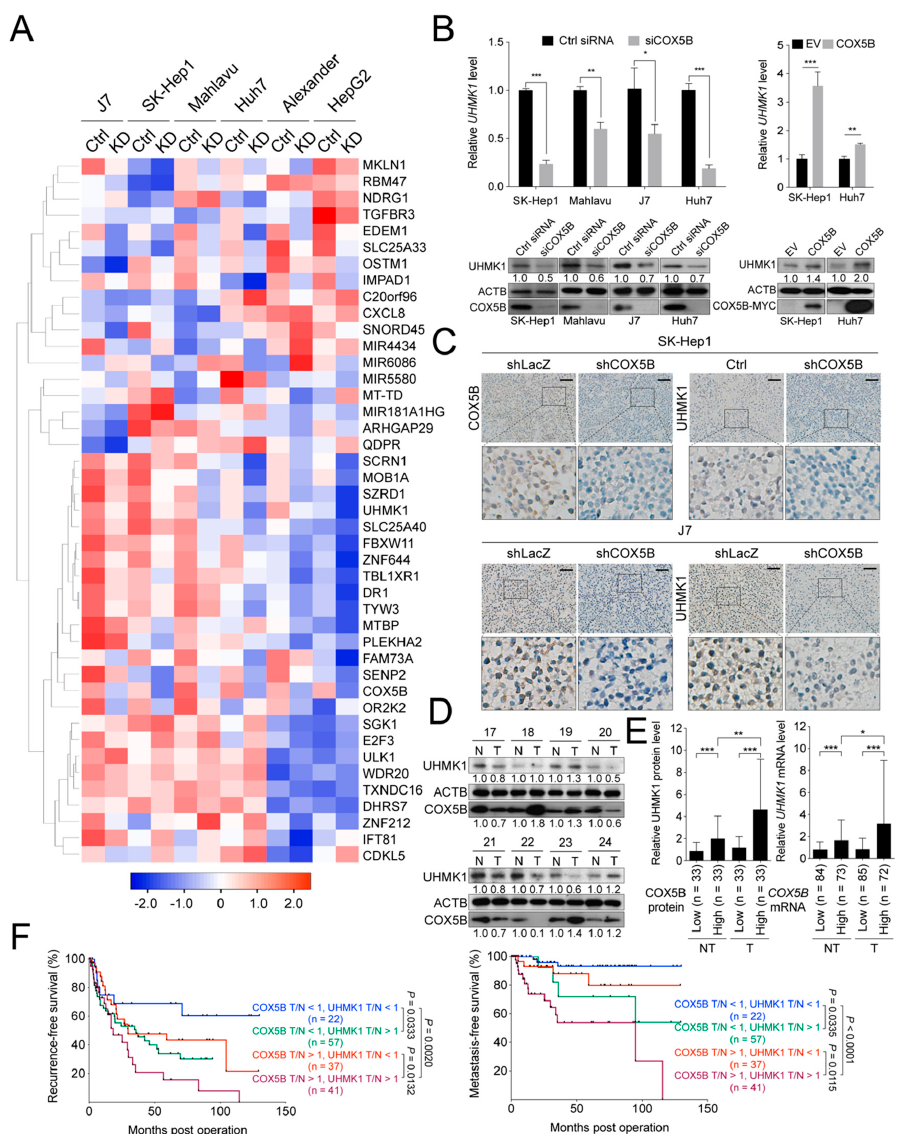
Figure 4. COX5B modulates UHMK1 expression in hepatoma. ( A ) The heat map representation of the relative gene expression levels in hepatoma cells receiving control treatment (Ctrl) and knockdown of COX5B (KD). The average linkage method was used for hierarchical clustering. The distances between rows and columns were computed by Pearson method. ( B ) RT-qPCR and western blot were performed for validation of UHMK1 expression changes under depletion of COX5B. All the in vitro cell-based assays shown in ( B ) were conducted in duplicates. ( C ) IHC staining of paraffin-embedded tissues derived from Figure 2E. The expression relationships between COX5B and UHMK1 in ( D ) protein and ( E ) mRNA levels in samples derived from hepatoma patients. The p value was derived from paired two-tail student t -test. *, p < 0.05; **, p < 0.01; ***, p < 0.001. The western blot images in ( B , D ) were all acquired by exposing the luminescent signals to X-ray films. ( F ) The Kaplan-Meyer analysis of recurrence-free and metastasis-free survival in hepatoma patients stratified according to the T / N ratio of COX5B and UHMK1 mRNA